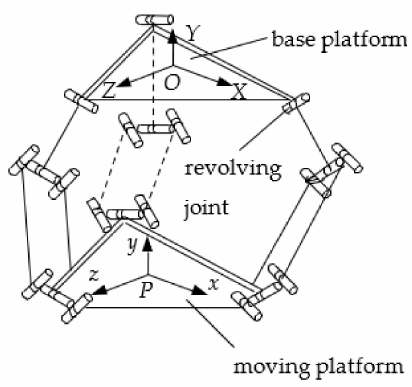
Figure 2. Kinematic sketch of the improved Delta